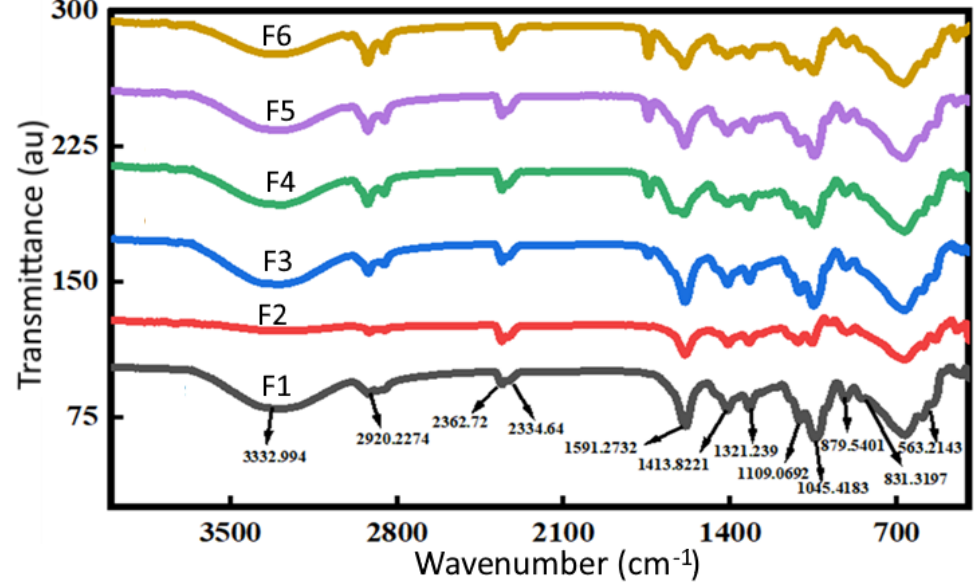
Figure 3. The FT-IR spectra of biocomposite films. For sample codes F1 to F6, refer to Table